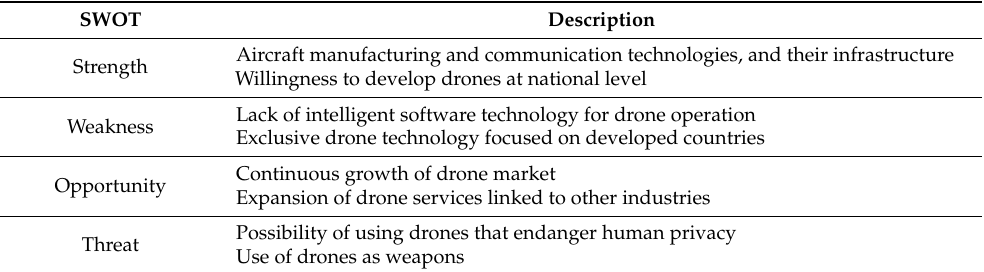
Table 2. SWOT of drone technology.